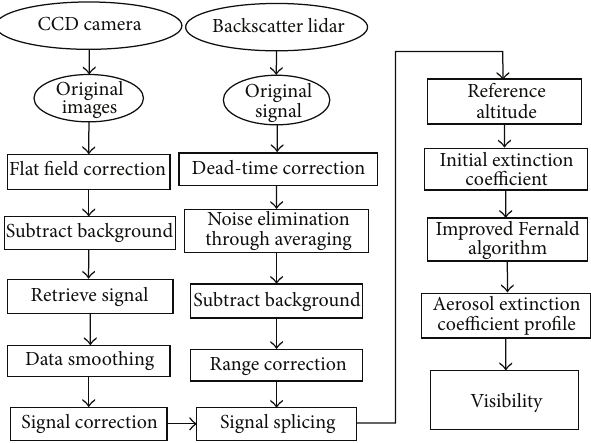
Figure 2: The flow chart of the data